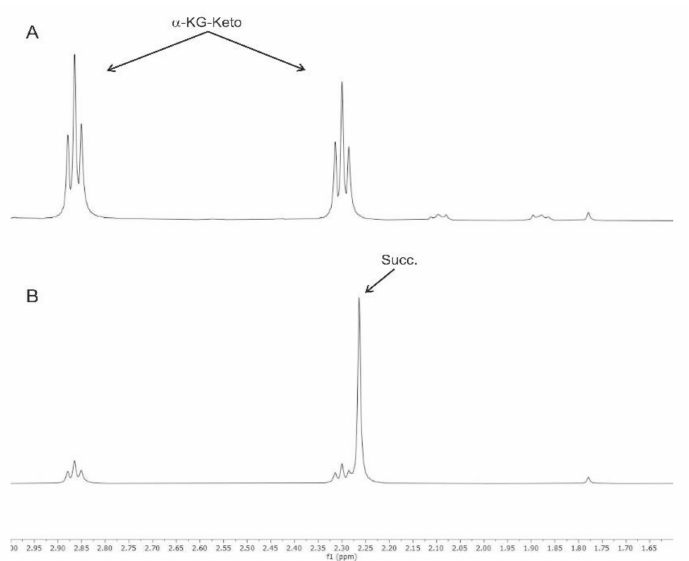
Figure 1. NMR spectra of 2-oxoglutarate ( α KG) before and after the reaction with 2 mM ONOO − at pH 6.0 ( A ) and after the reaction with 2 mM peroxynitrite at pH 7.4 ( B